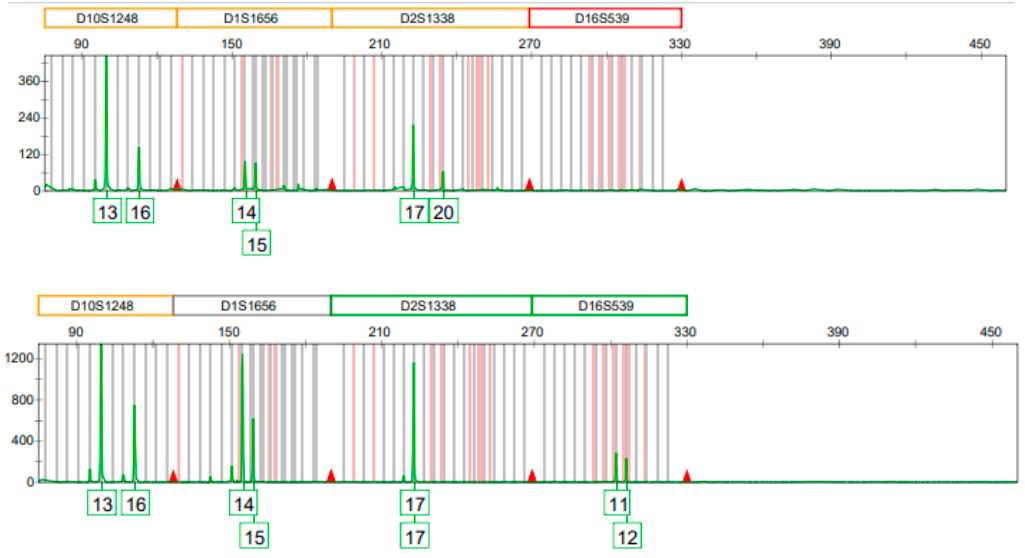
Figure A4. Electropherograms of markers D10S1248, D1S1656, D2S1338, and D16S539 (labeled with JOE-6C) of samples RF2 ( above ) and LF2 ( below ).